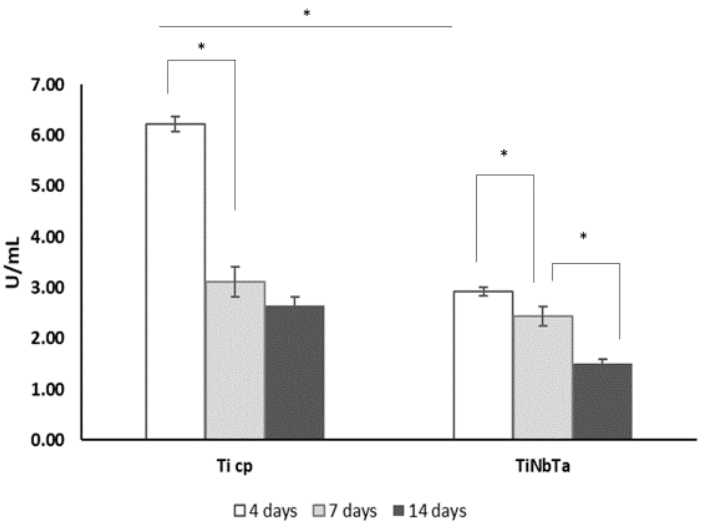
Figure 6. Alkaline phosphatase activity in cell growth on discs of fully dense Ti or TiNbTa at 4, 7, and 14 days. * p < 0.05.